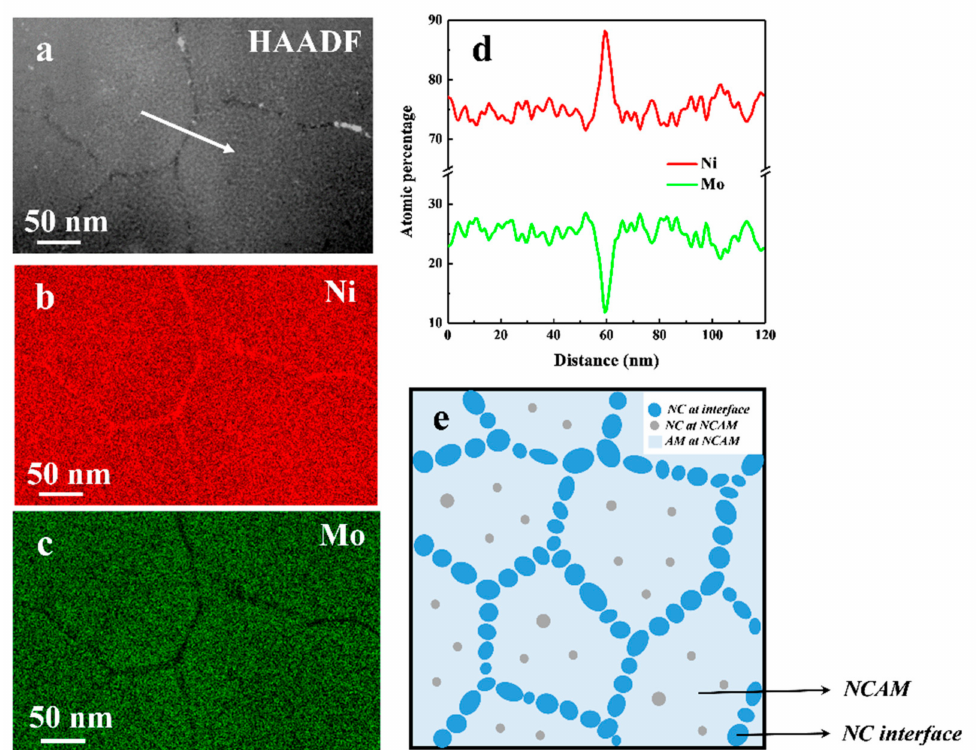
Figure 2. Chemistry analysis of the as-deposited Ni-26Mo alloy. ( a ) A high angle annular dark field (HAADF) image of Ni-26Mo. Energy dispersive spectroscopy (EDS) mapping of nickel ( b ) and molybdenum ( c ) in the same region of ( a ), indicating an obvious enrichment of Ni and depletion of Mo at NC interface. ( d ) Composition profile of Ni and Mo across NC interface as indicated by the white arrow in ( a ), showing the atomic percentage of Ni is 88 with that of Mo is 12. ( e ) A schematic illustration of nanocrystalline/nanocrystalline and amorphous (NC/NCAM) composite structure of